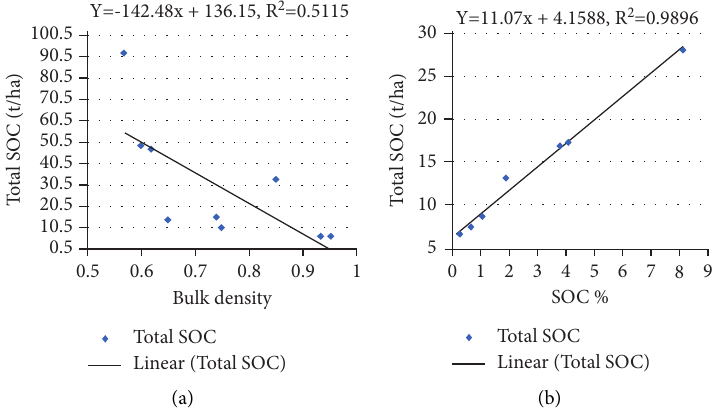
Figure 5: (a) SOC stocks (t/ha) and BD. (b) SOC stock (t/ha) with SOC concentration in upper mixed hardwood forest.